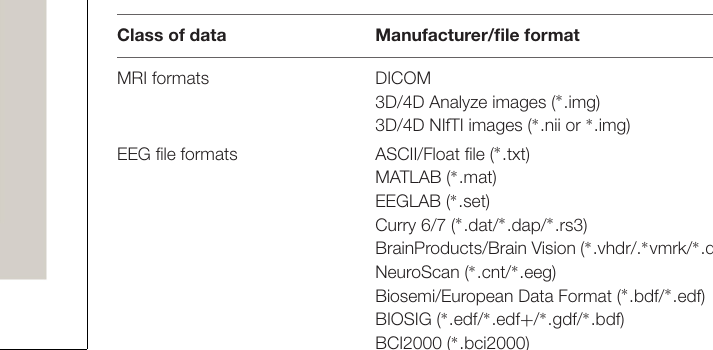
TABLE 1 | File formats supported by NIT